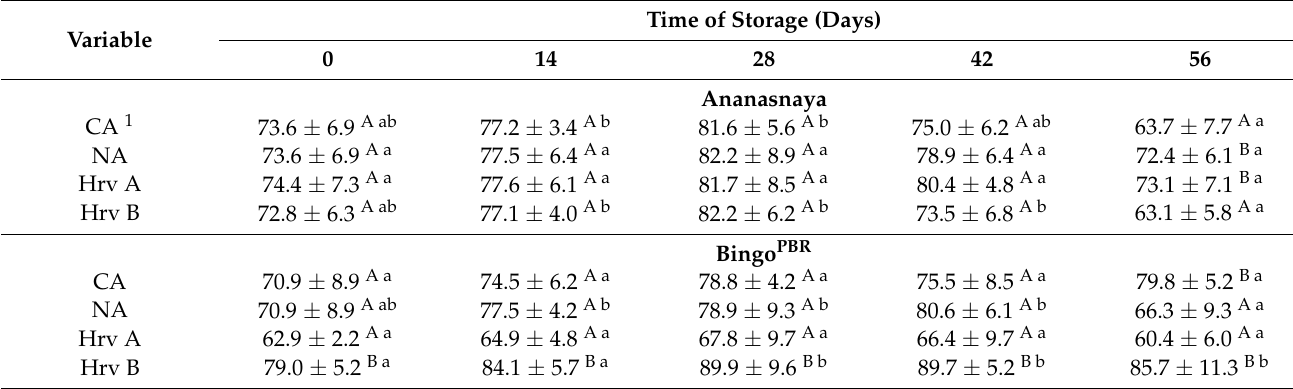
Table 8. Changes of ascorbic acid [mg · 100 g − 1 f.w.] measured in ‘Ananasnaya’ and ‘Bingo’ PBR minikiwi fruit in posthar- vest